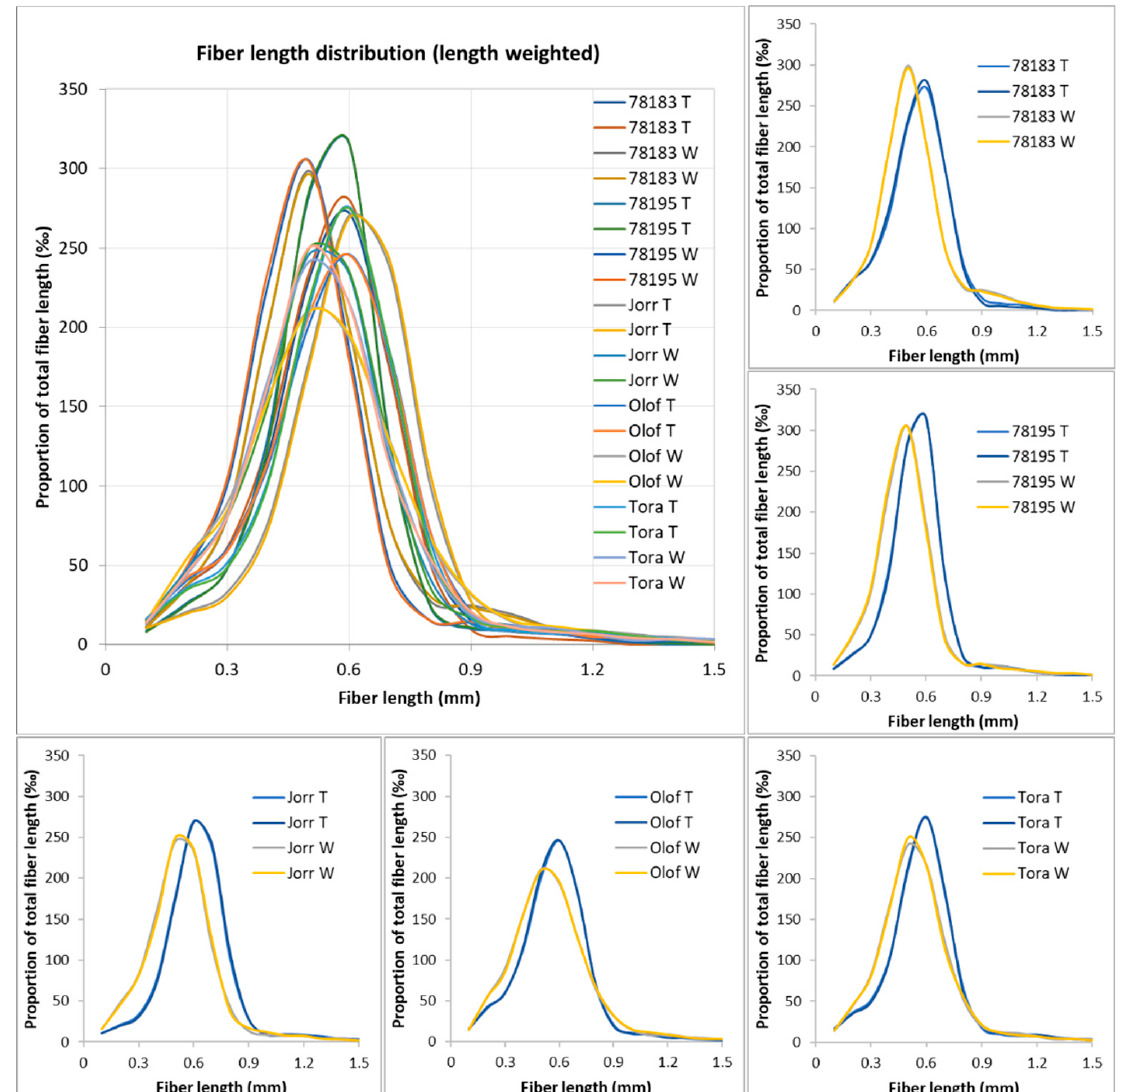
Figure 8. Fiber length distribution (length weighted) of whole and tension wood regions from S. viminalis clones and commercial varieties.